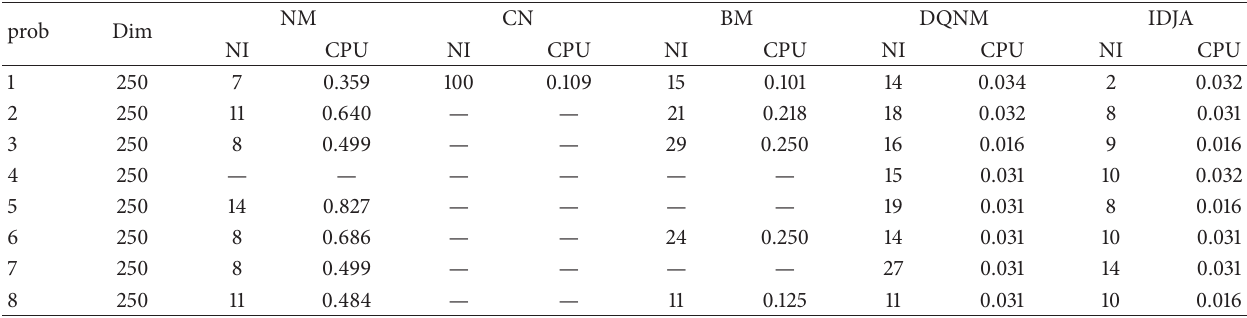
Table 3: Numerical Results of NM, CN, BM, DQNM, and IDJA methods.